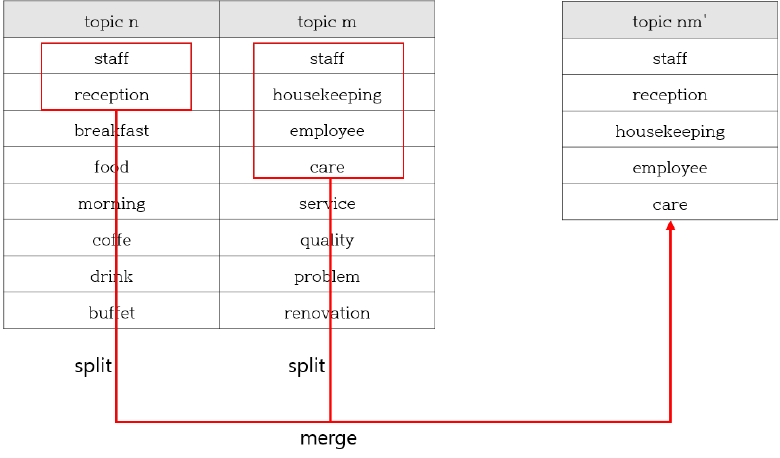
Figure 6. A real example of split and merge